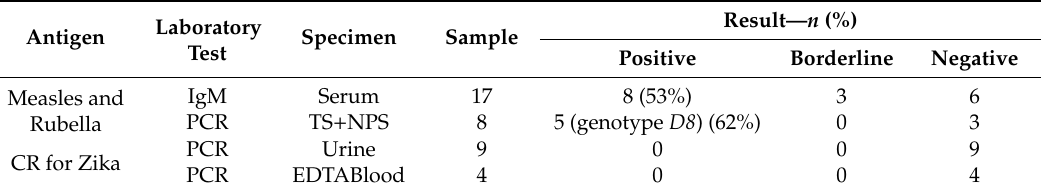
Table 4. Number of specimen samplings and the laboratory findings on measles, zika, and rubella.